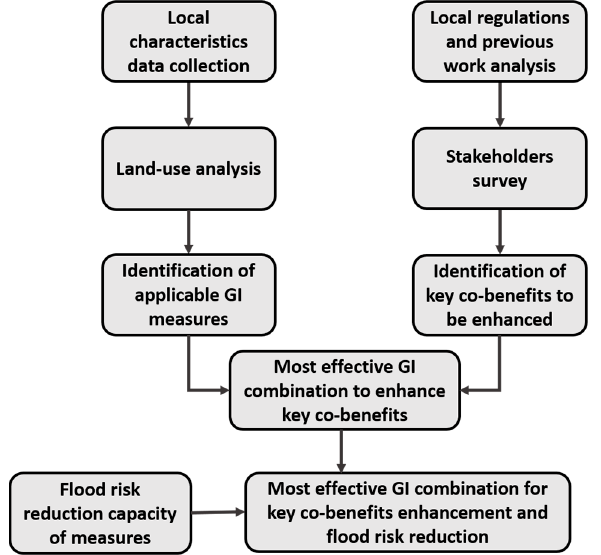
Figure 2. Methodological steps for the selection of the most effective green infrastructure (GI)